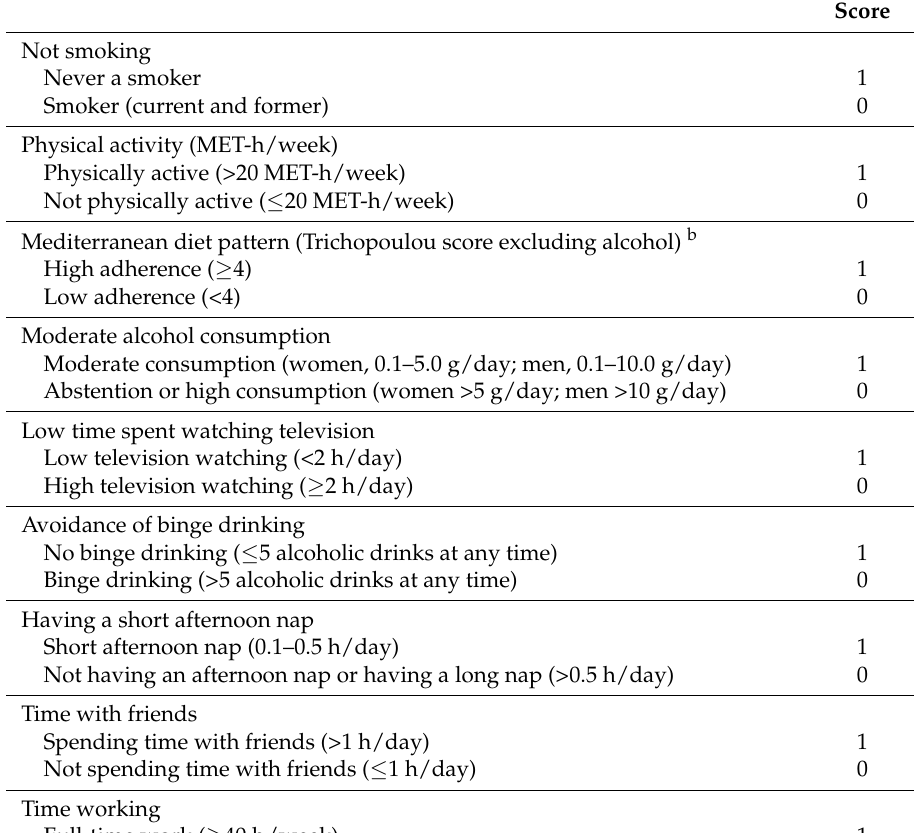
Table 1. Healthy Lifestyle Score (HLS) a